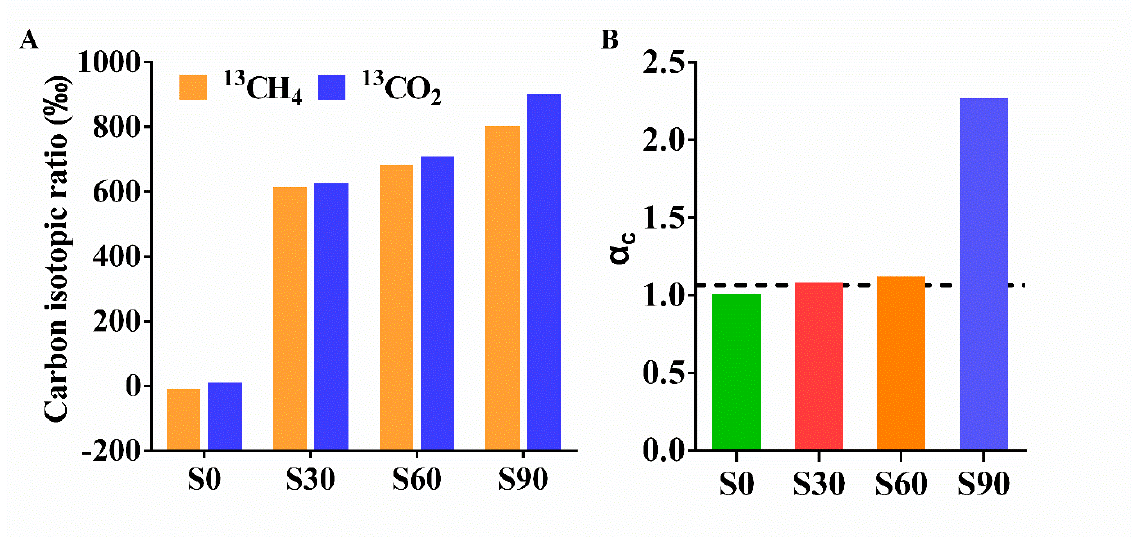
Figure 2. Carbon stable isotope ratios of methane and carbon dioxide and apparent fractionation factors in different enrichments after 230 days of anaerobic incubation. The dashed line represents 1.065. ( A ) Carbon stable isotope ratios of methane and carbon dioxide in different enrichments; ( B ) Apparent fractionation factors in different enrichments.